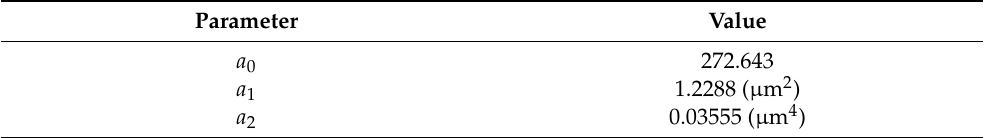
Table 1. Constants for variation of refractive index, n ; see Equation (1).